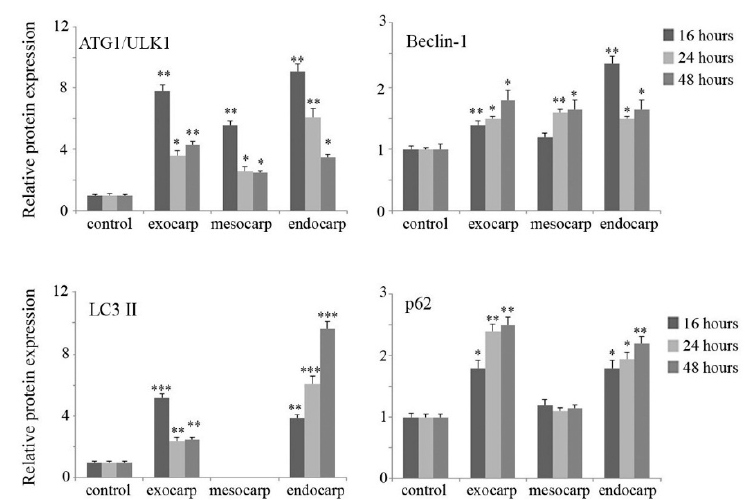
Figure 5. Time course evaluation of autophagic markers after treatment with litchi extracts. Cells were treated for the indicated times with 150 µg/mL GAE litchi exocarp, mesocarp or endocarp extracts. The cells were then harvested and protein extracts were prepared and subjected to western blotting analysis to determine the levels of autophagic markers. ATG1/ULK1 (autophagy related 1/Unc-51 like autophagy activating kinase), LC3 (microtubule associated protein 1 light chain 3). The correct protein loading was ascertained by immunoblotting for γ -tubulin. Representative blots of three independent experiments are shown. Densitometric analyses are present in supplementary data. (*) p < 0.05; (**) p < 0.01; (***) p < 0.001 compared with control.